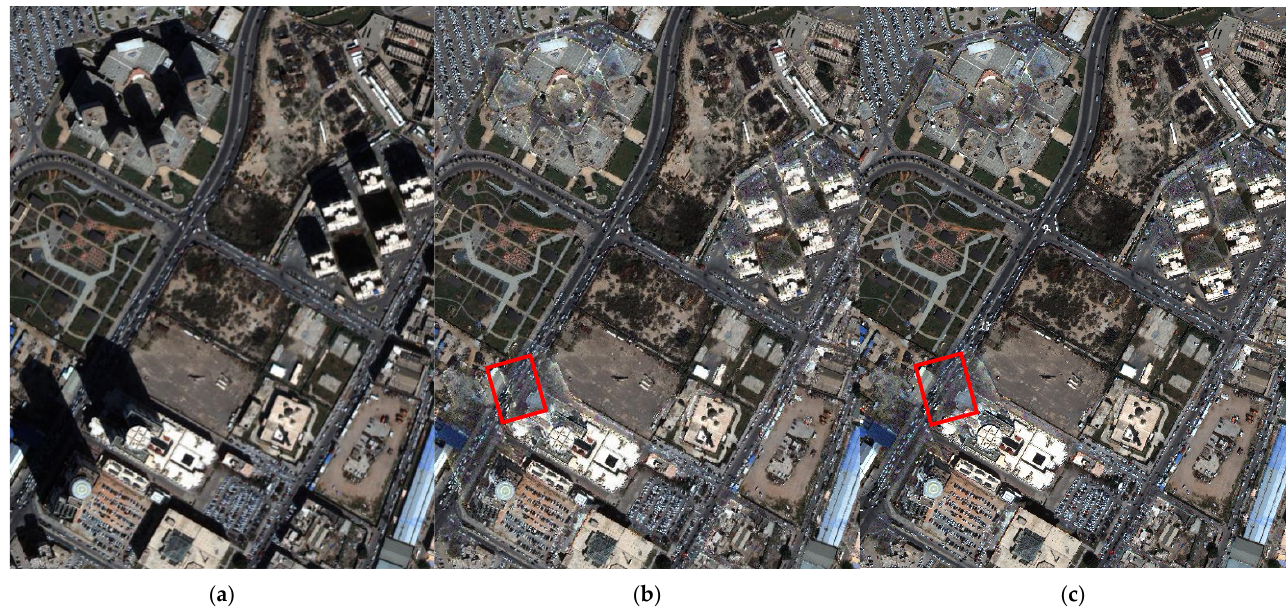
Figure 14. Results of experimental data 1: ( a ) original image; ( b ) result of shadow compensation; and ( c ) result of penumbra removal.